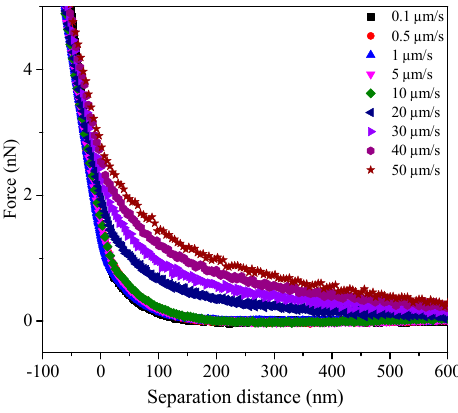
Figure 4. Interaction force between hydrophilic glass microsphere and bubble with different collision velocities.